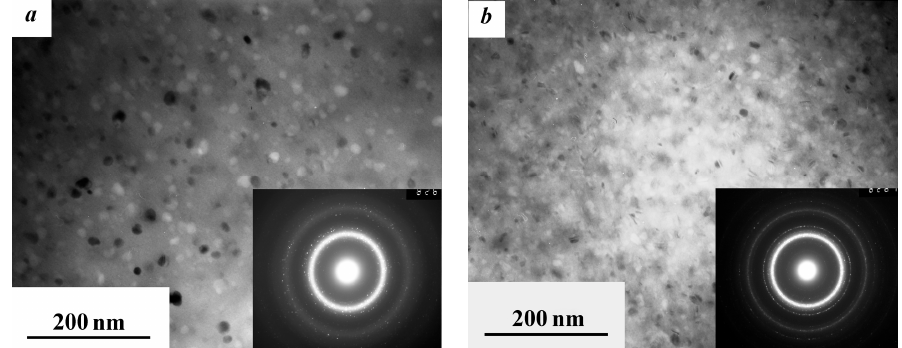
Figure 6. Bright-field images (TEM) of the composite structure after HPT to N = 3 ( a ) and N = 7 ( b ) and the corresponding SAED patterns.